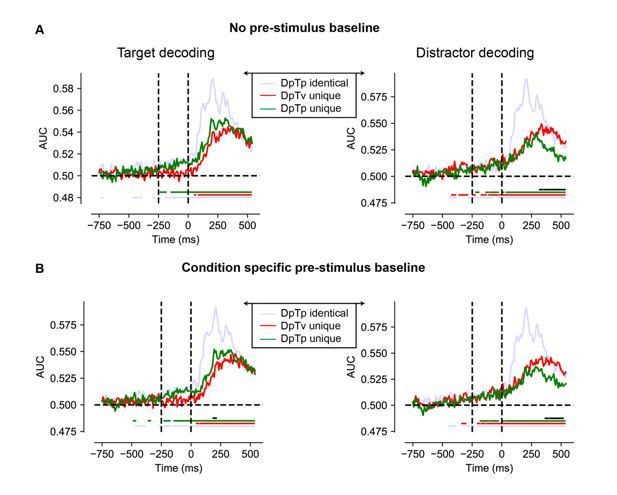
Multivariate decoding of the target and distractor spatial frequency across conditions using broad-band EEG of all 64 electrodes.(A) AUC scores of target (left) and distractor (right) decoding across time without a pre-stimulus baseline. (B) AUC scores of target (left) and distractor (right) decoding across time with a condition specific pre-stimulus baseline. Colored bars on the x-axis (blue; red; green) indicate clusters where conditions differ significantly from chance after cluster correction (p <0.05). Black lines indicate clusters with a significant difference between DpTv unique and DpTp unique conditions after cluster correction (p <0.05).